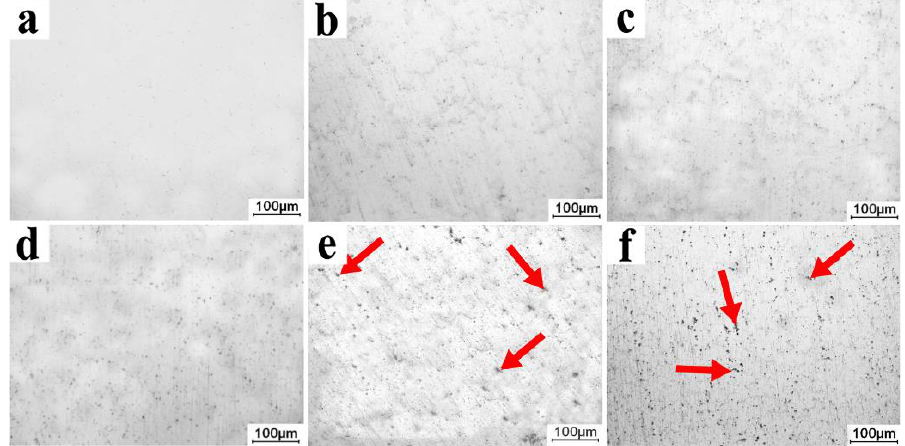
Figure 7. The dispersion of Grp with different Grp contents: ( a ) 0 wt.%, ( b ) 0.5 wt.%, ( c ) 1.0 wt.%, ( d ) 1.5 wt.%, ( e ) 2.0 wt.%, and ( f ) 2.5 wt.%. (Red arrows: the particles of Grp).